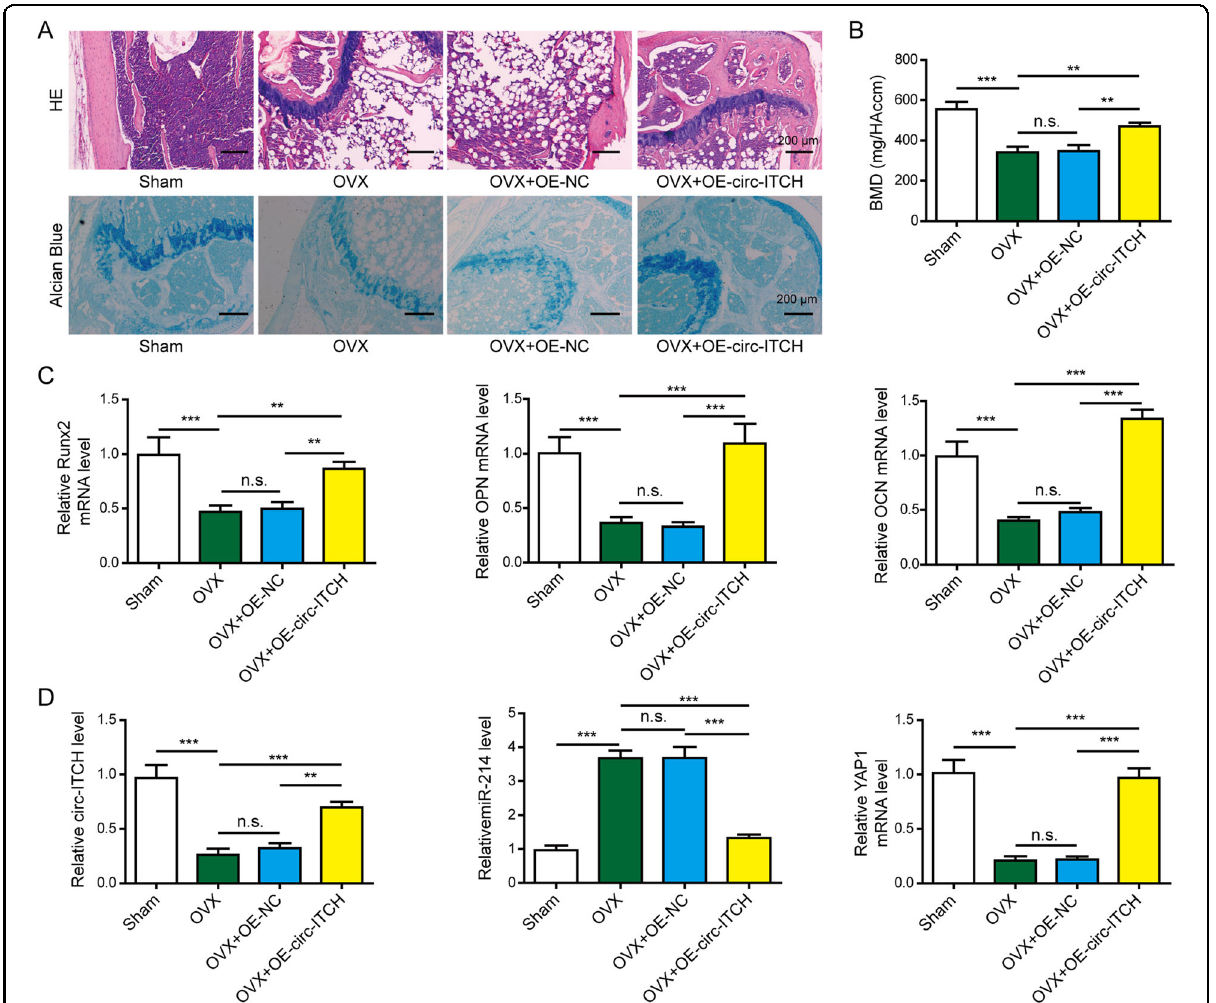
Fig. 7 Overexpression of circ-ITCH alleviated the symptoms of osteoporosis in OVX mice. Mice were randomly divided into four groups: Sham, OVX, OVX + OE-NC, and OVX + OE-circ-ITCH groups. OE-circ-ITCH or OE-NC lentiviral vector was injected into OVX mice through tail intravenous injection. A Representative images of bone tissue sections after HE staining and Alcian Blue staining. Scale bar: 200 μ m. B BMD of femurs was measured using Dual-energy X-ray absorptiometry. C RT-qPCR analysis of RUNX2, OPN, and OCN levels in the bone marrow samples. D RT-qPCR analysis of circ-ITCH, miR-214, and YAP1 levels in the bone marrow samples. ** P < 0.01, *** P < 0.001, and n.s. not signi fi